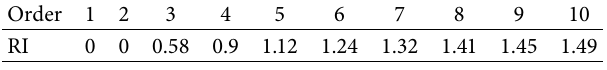
Table 2: RI values under different orders.